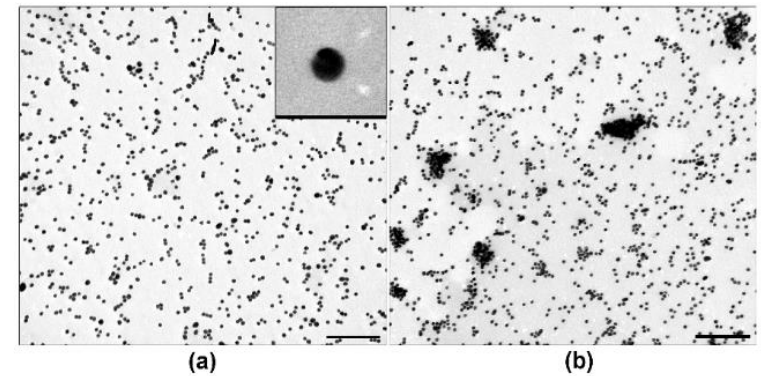
Figure 2. Transmission electron microscopy of cores (siRNA-Au), 22 h of incubation: Highly dispersed suspension of Sample II ( a ); and core agglomeration in Sample I ( b ). Insert shows spherical core at high magnification, length of bottom side corresponds to 40 nm. Length of scale bars corresponds to 200 nm.